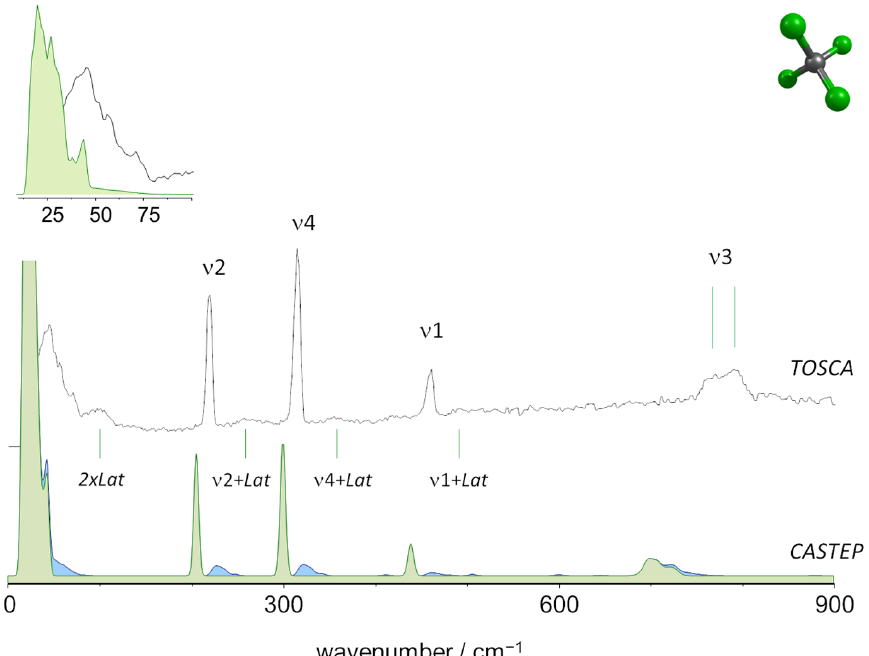
Figure 1. The INS spectra of tetrachloromethane (carbon tetrachloride) up to 900 cm − 1 : Experimental (top, TOSCA) and simulated from periodic calculations (bottom, CASTEP). Colors indicate the intensity contributions from fundamental modes (green) and two-quanta events (blue). “Lat” stands for librational and translational lattice modes. Inset: detail of the low wavenumber region.